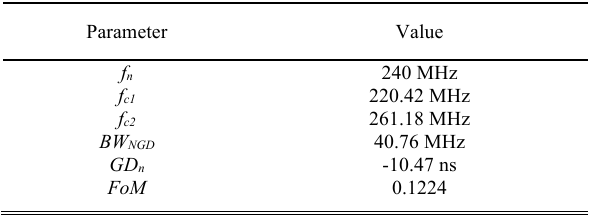
TABLE II. Targeted BP NGD